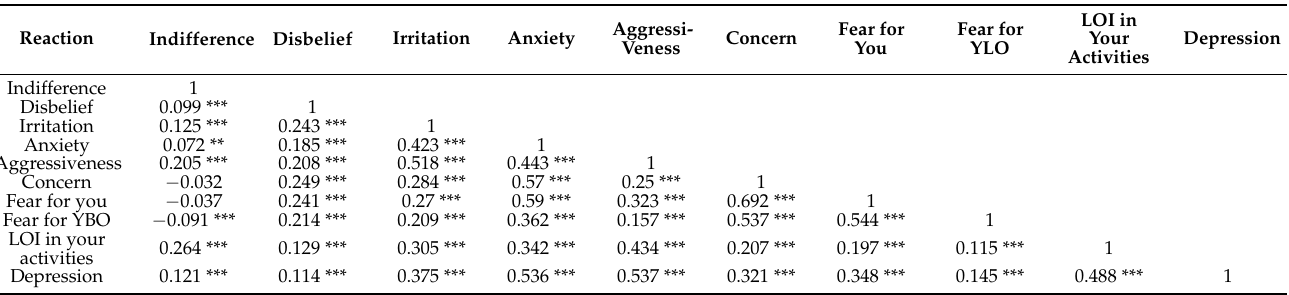
Table 4. Correlation matrix of the whole